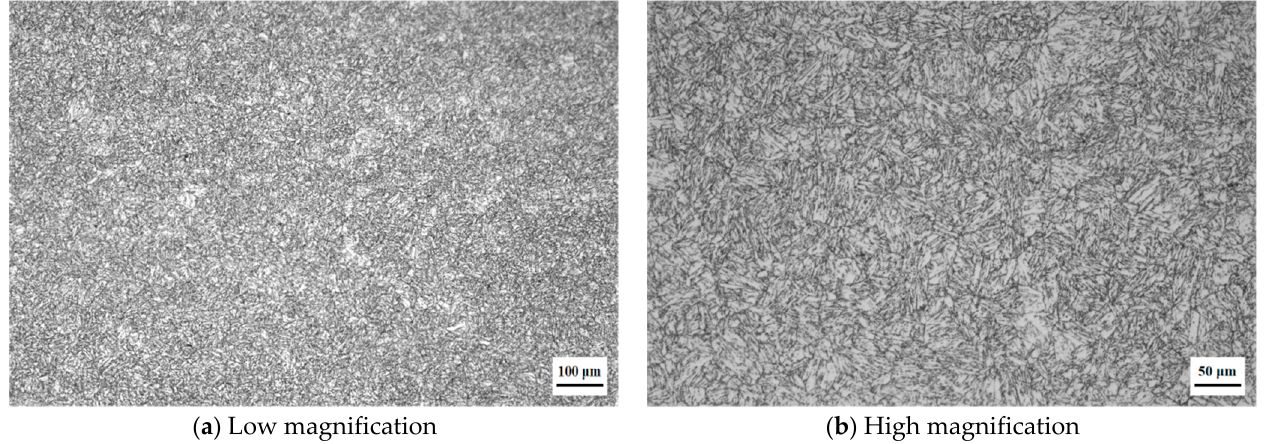
Figure 1. Metallographic microstructure of Super 13Cr: ( a ) low magnification, ( b ) high magnification.